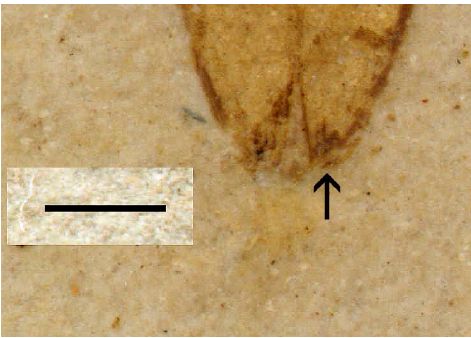
Figure 2. Apoclion antennatus Chang, Kirejtshuk & Ren, holotype. Elytral apices with specialized pores (arrow). Scale 1 mm.